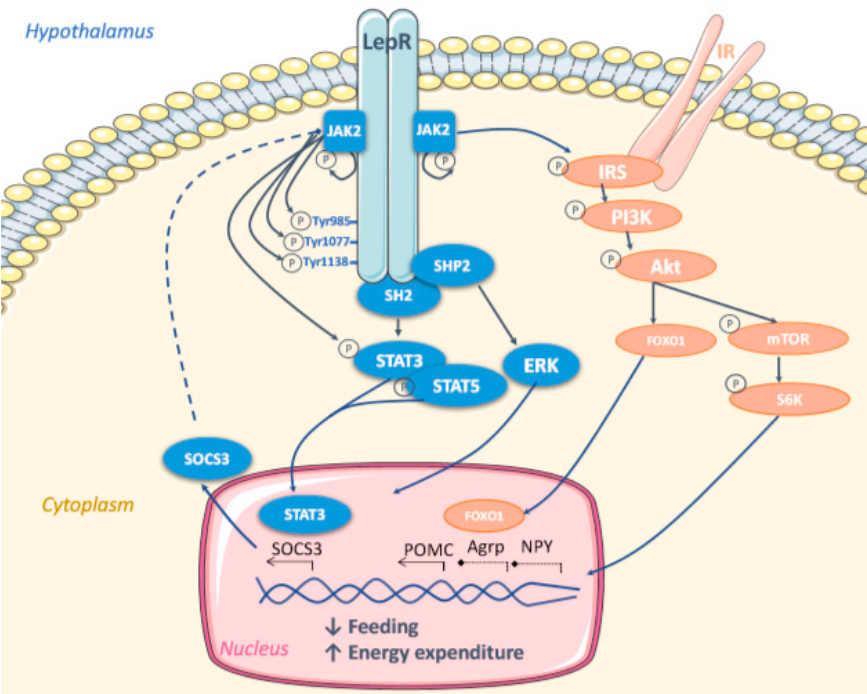
Figure 3. Leptin-induced pathways. The binding of leptin to its receptors (LepR), mainly expressed in the hypothalamus, leads to its dimerization and recruitment and auto-phosphorylation of Janus tyrosine kinase 2 (JAK2). JAK2 subsequently phosphorylates LepR on 3 distinct tyrosine residues (Tyr985, Tyr1077 and Tyr1138), facilitating the binding of Src Homology 2 (SH2) containing molecules. Depending on the phosphorylated tyrosine, different pathways will be activated. Phosphorylation at Tyr985 allows the binding of (i) Suppressor Of Cytokine Signalling 3 (SOCS3) inducing negative feedback to inhibit JAK2 and (ii) SH2 domain protein tyrosine phosphatase 2 (SHP2) to activate Extracellular-signal Regulated Kinase (ERK) pathways. The Tyr1077 permits the phosphorylation and activation of Signal Transducer And Activator of Transcript 5 (STAT5) leading to gene expression changes. Finally, the Tyr1138 allows the phosphorylation of STAT3 altering gene expression and activating SOCS3, reinforcing the negative JAK2 feedback. Furthermore, the leptin pathway is interconnected with the insulin pathway, since JAK2 activation phosphorylates Insulin Receptor (IR) and Substrate (IRS), and subsequently, Phosphatidyl Inositol 3 Kinase (PI3K), protein kinase B (Akt) leading to the activation of Forkhead box protein O1 (FOXO1) and also mammalian Target Of Rapamycin (mTOR)/ribosomal S6 kinase (S6K). Together, all these leptin-activated signalling pathways trigger energy homeostasis gene regulation, mainly consisting in over-transcription of anorexigenic Pro-opiomelanocortin (POMC) and down-transcription of orexigenic Agouti Related Protein (Agrp) and Neuropeptide Y (NPY) neuropeptides, as well as favouring energy expenditure genes, including thermogenic markers.